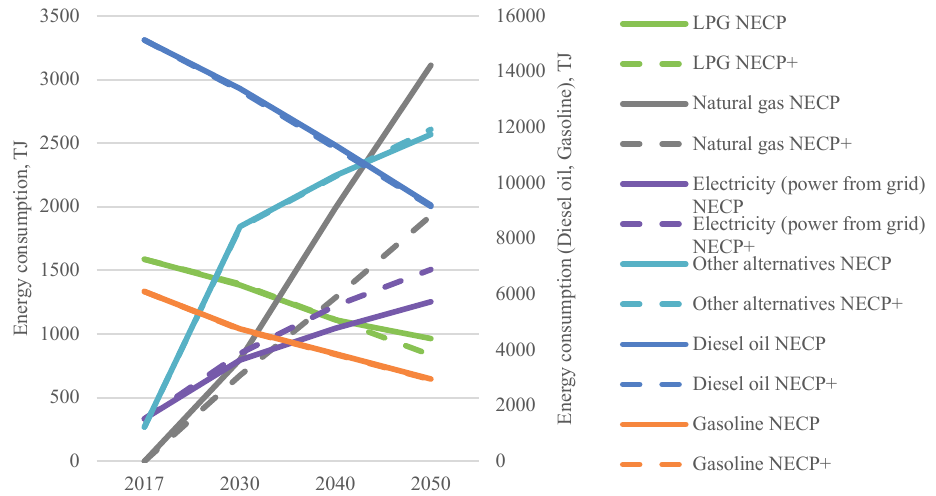
Fig.12. Results of sensitivity analysis – fuel consumption in NECP and